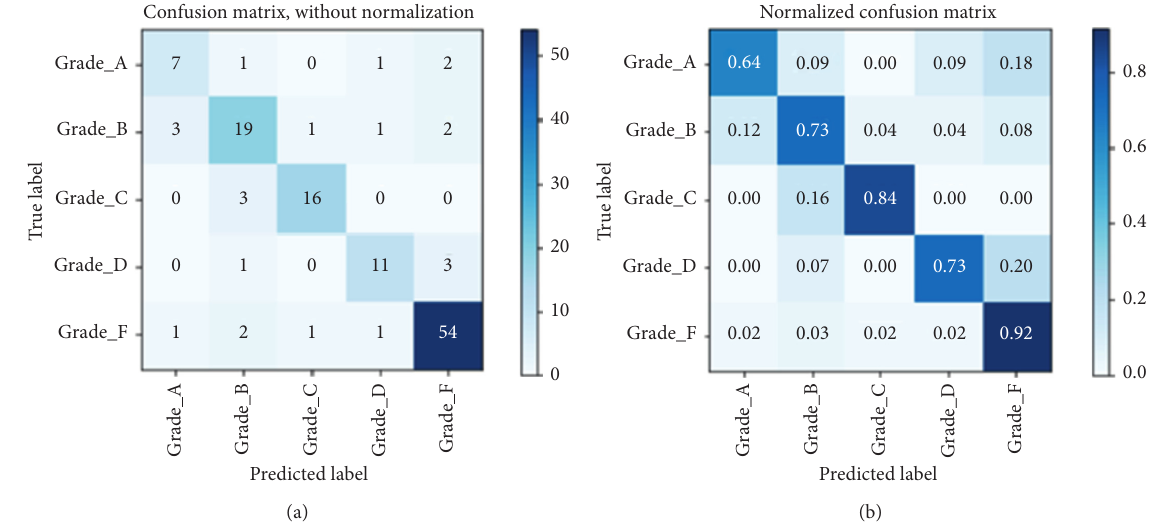
Figure 8: Confusion matrices of M-learning model 1, without normalization and normalized confusion matrix. (a) Without normalization. (b) With normalization.